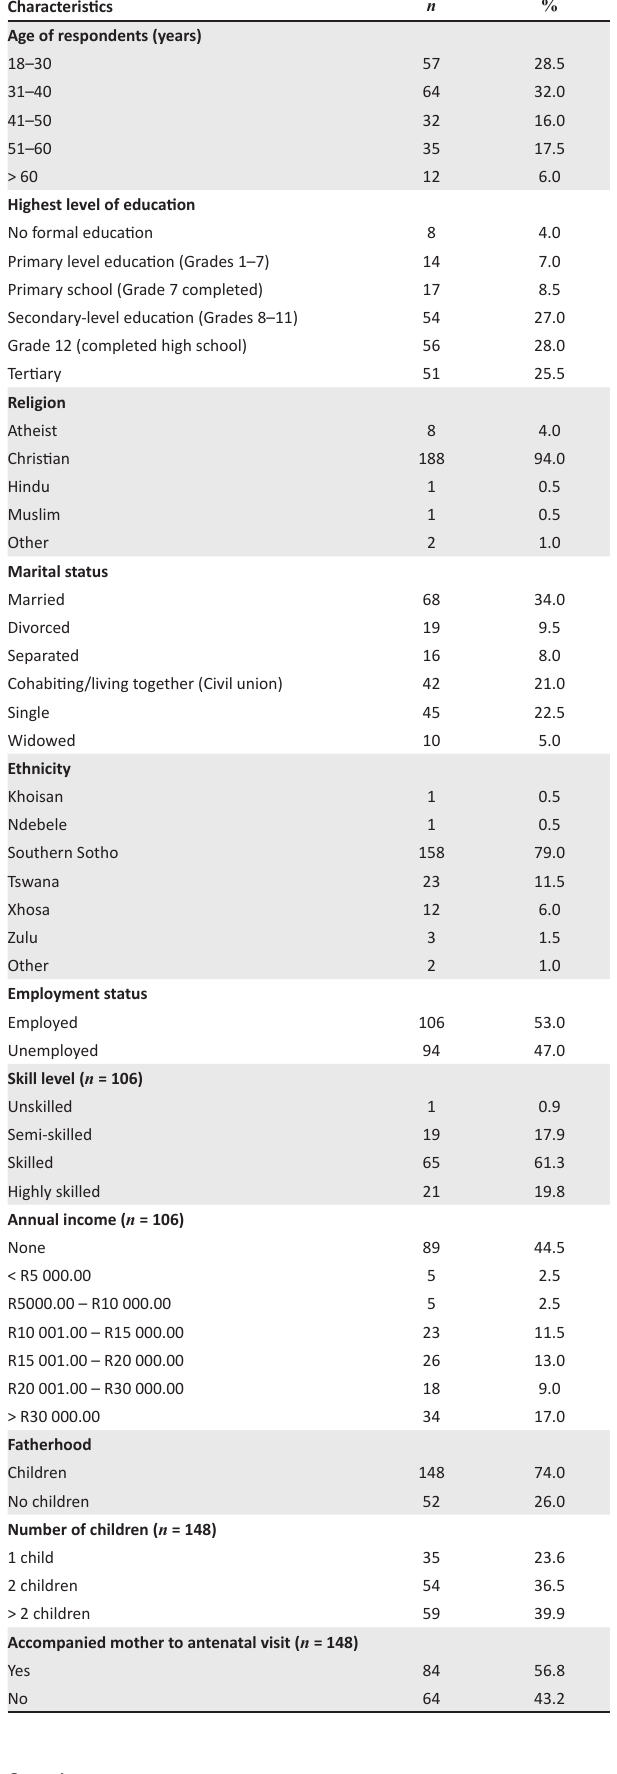
TABLE 1 : Sociodemographic characteristics of the participants.